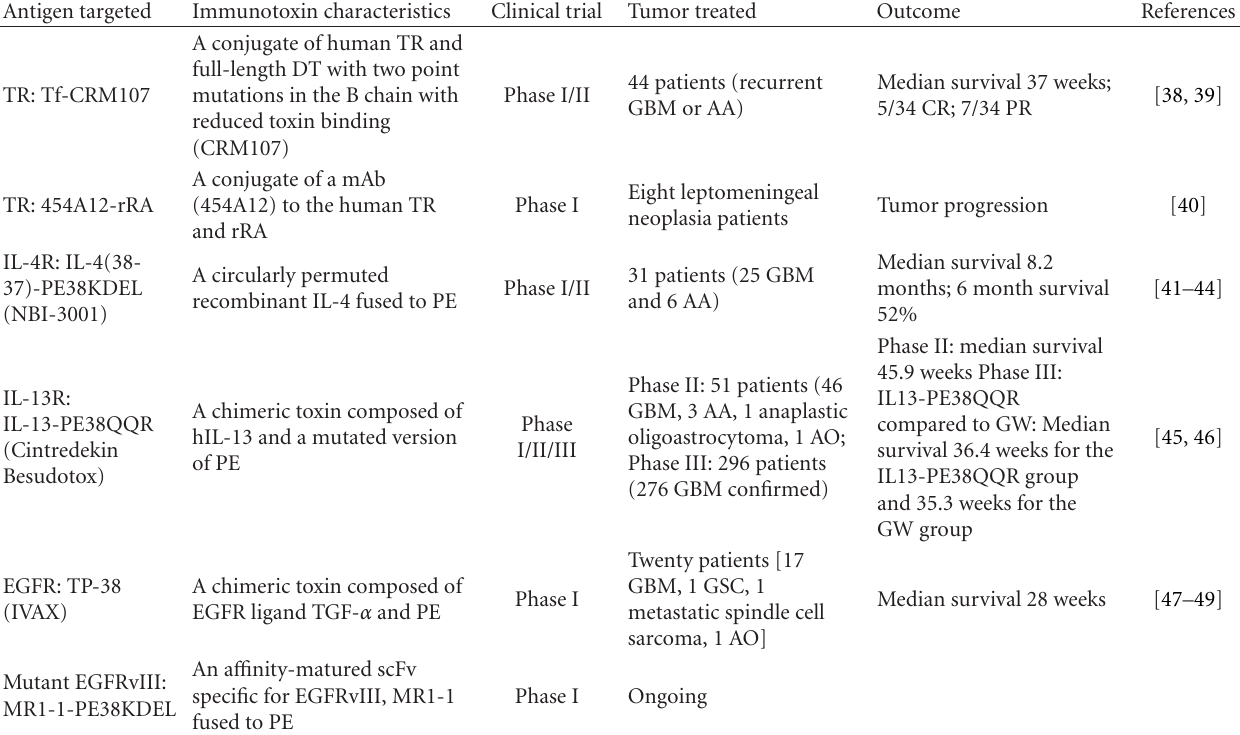
Table 1: Current listing of immunotoxin trials for brain tumor